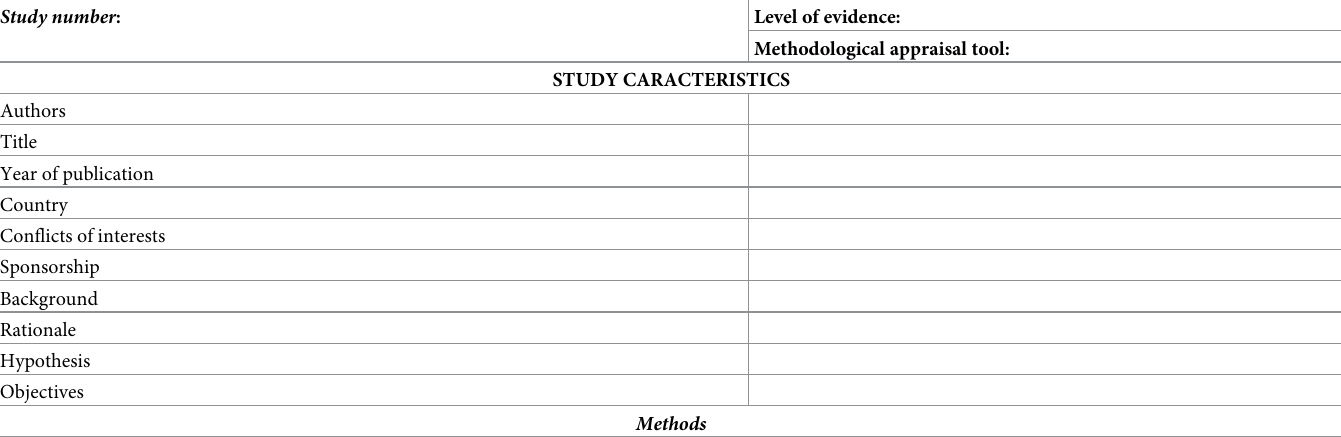
Table 2. The data extraction form was based on previous publications [22, 24, 25,